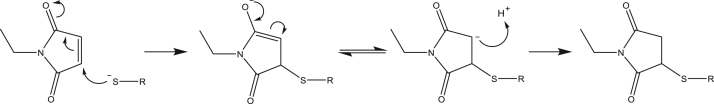
Mechanism of the reaction between N-ethylmaleimide and thiols (RSH) in aqueous solution. R- alkyl chain with additional functional groups (as in aminothiols), hydrogen (as for sulfide) or sulfur chains of various length (as in polysulfides).